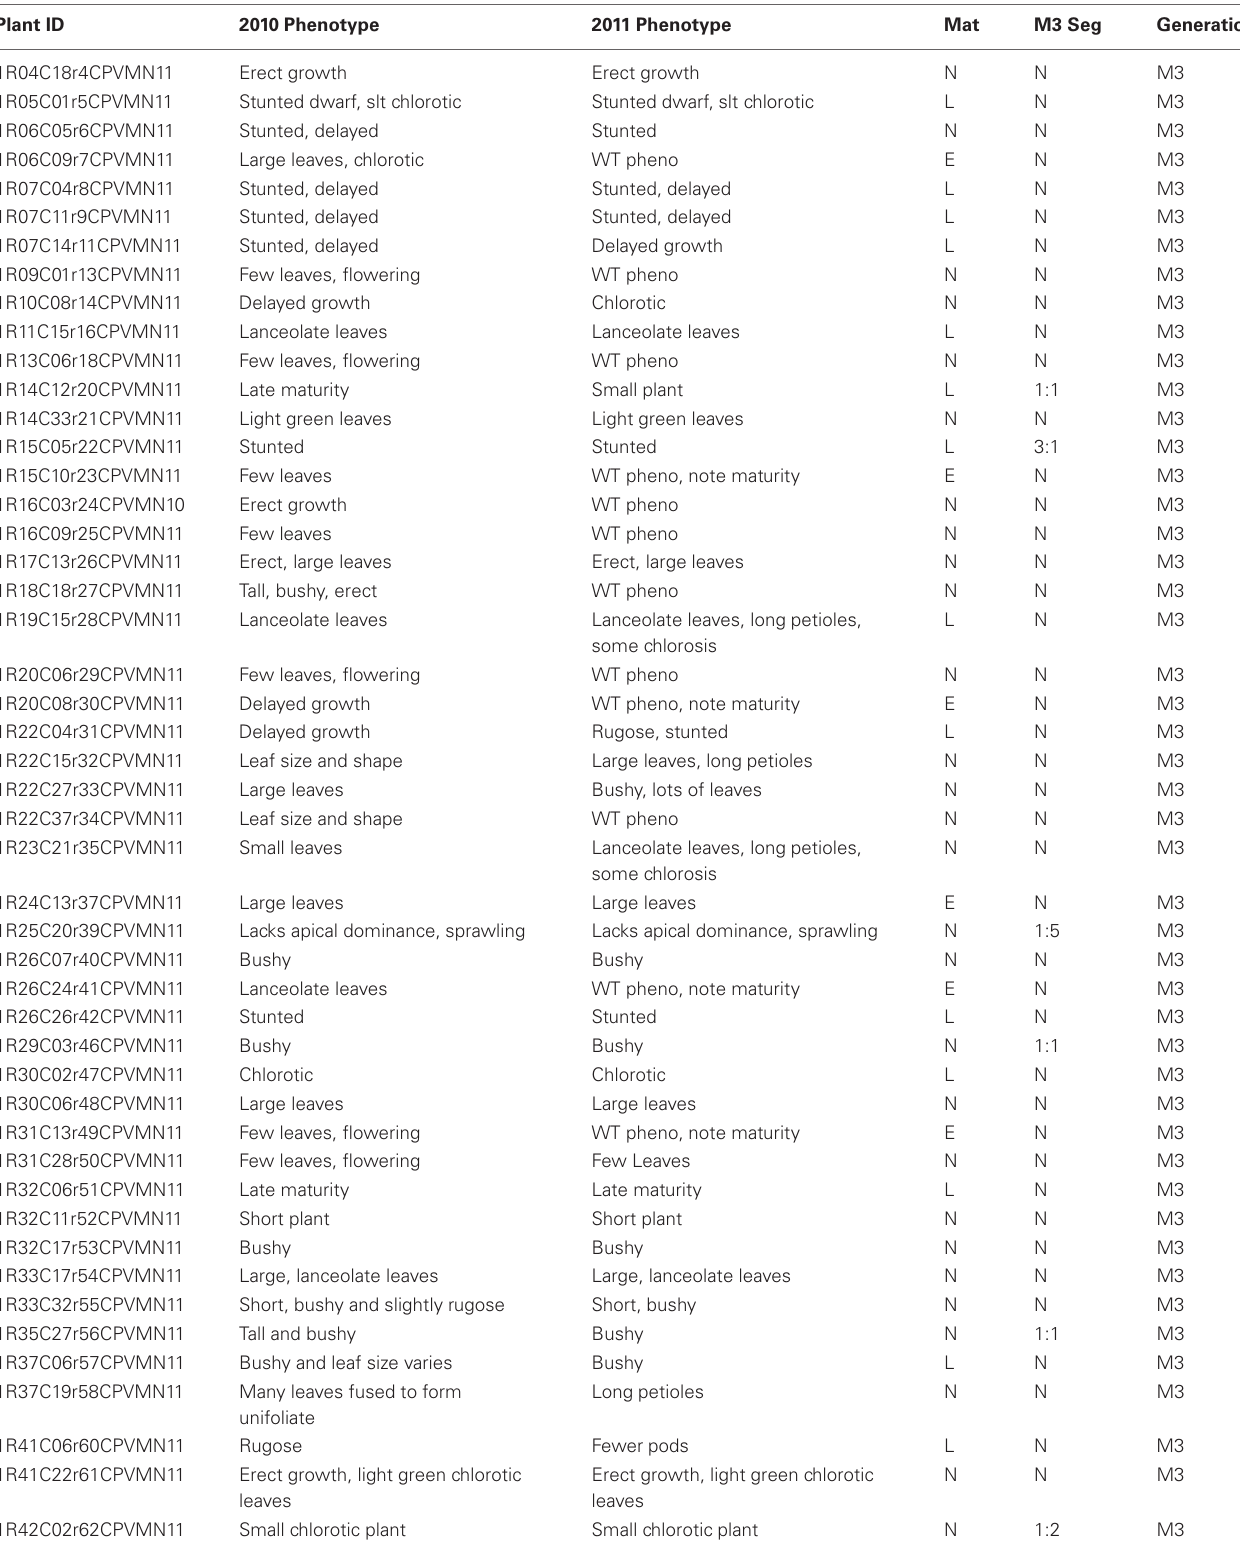
Table 1 | Phaseolus vulgaris cv. Red Hawk fast neutron mutant population. Plant